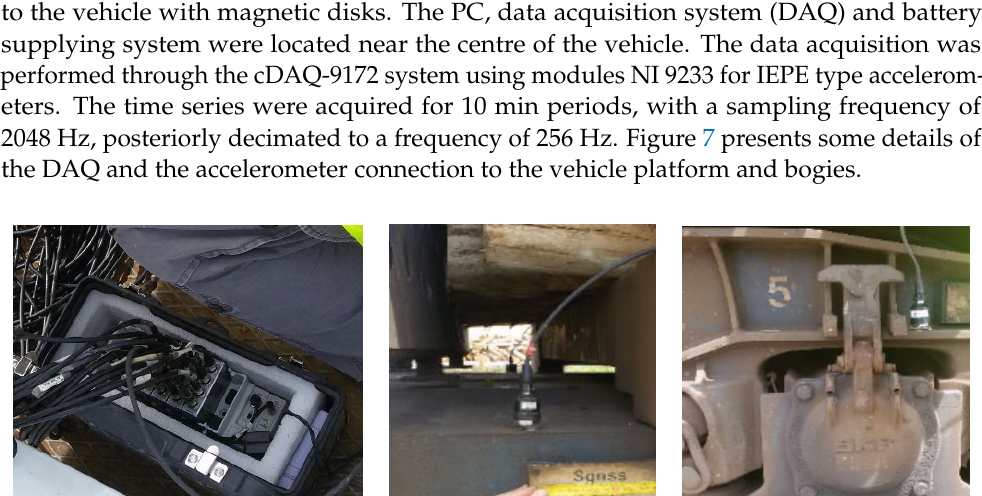
Figure 7. Dynamic tests of Sgnss wagon: DAQ and accelerometers on the platform and